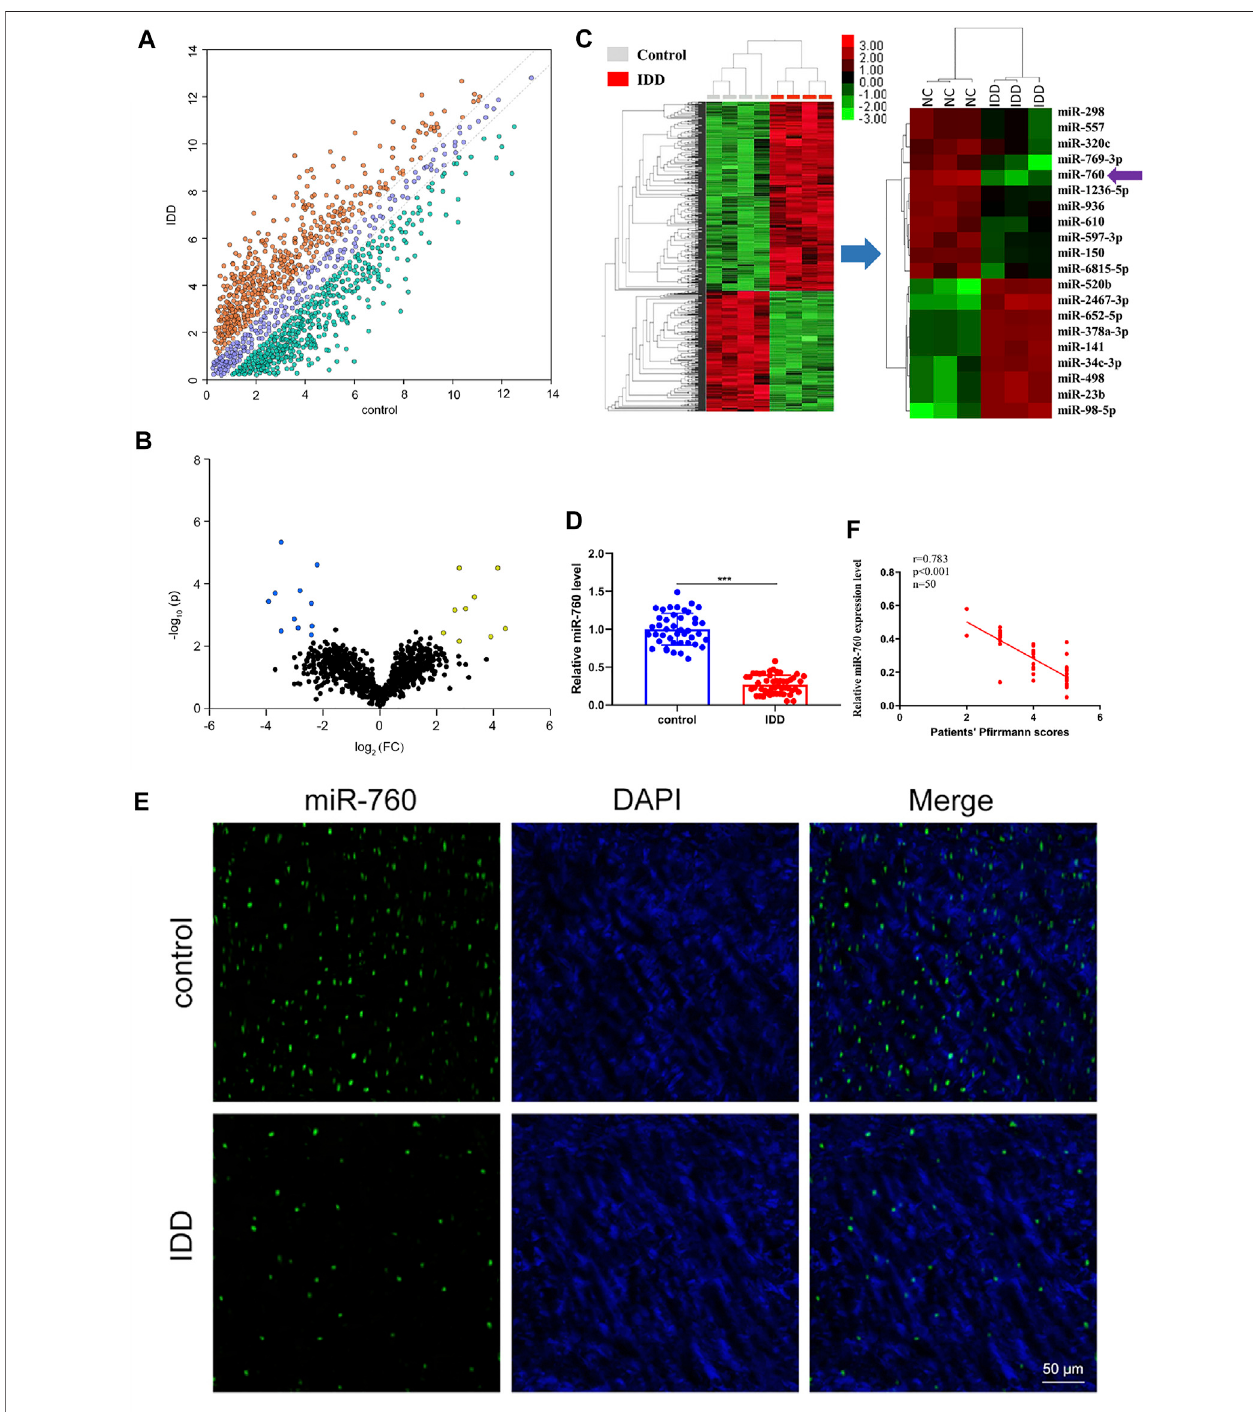
FIGURE 1 | Identi fi cation of differentially expressed miRNAs in NP tissues of IDD patients. (A) Scatter plot of miRNA expression pro fi le between IDD patients and controls (yellow dots, up-regulation more than two-fold; green dots, down-regulation more than two-fold). (B) The biological and statistical signi fi cance of differently expressed miRNAs between IDD patients and controls were illustrated by Volcano plot. Yellow dots indicated the upregulated (right side) and blue dots indicated downregulated(leftside)miRNAs.MiR-760wasindicated. (C) TheheatmapsofdifferentlyexpressedmiRNAsinIDDpatients.The11-downregulatedandnineup- regulated miRNAs with the most obvious change were shown. (D) Compared with the control group (n = 43), miR-760 expression level was down-regulated in IDD patients (n= 50). *** p < 0.01 byMann – Whitney U test. (E) FISH analysis of NPtissues from IDD patients demonstrated that the level of miR-760 wasdecreased. (F) The expression of miR-760 in NP cells from IDD patients was negatively correlated with the disc degeneration grade (n = 50; r = 0.783, p < 0.001).